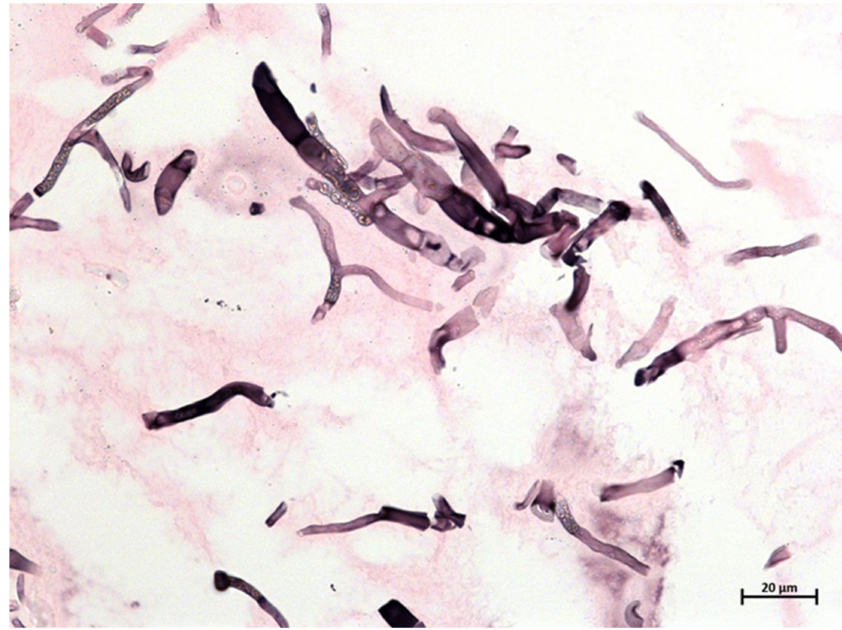
Figure 2. Grocott’s methenamine silver staining of sinus mucosal biopsy demonstrating diverse fungal elements, including broad, pauci-septate hyphae (5–10 µ m) in line with mucormycosis and thinner hyphae, mostly with right-angle branching suggestive of hyalohyphomycosis. Of note, the sequencing of a positive broad-range fungal PCR demonstrated a mixed amplicon suggestive of the presence of different fungi and, therefore, preventing the identification of a single causative fungal